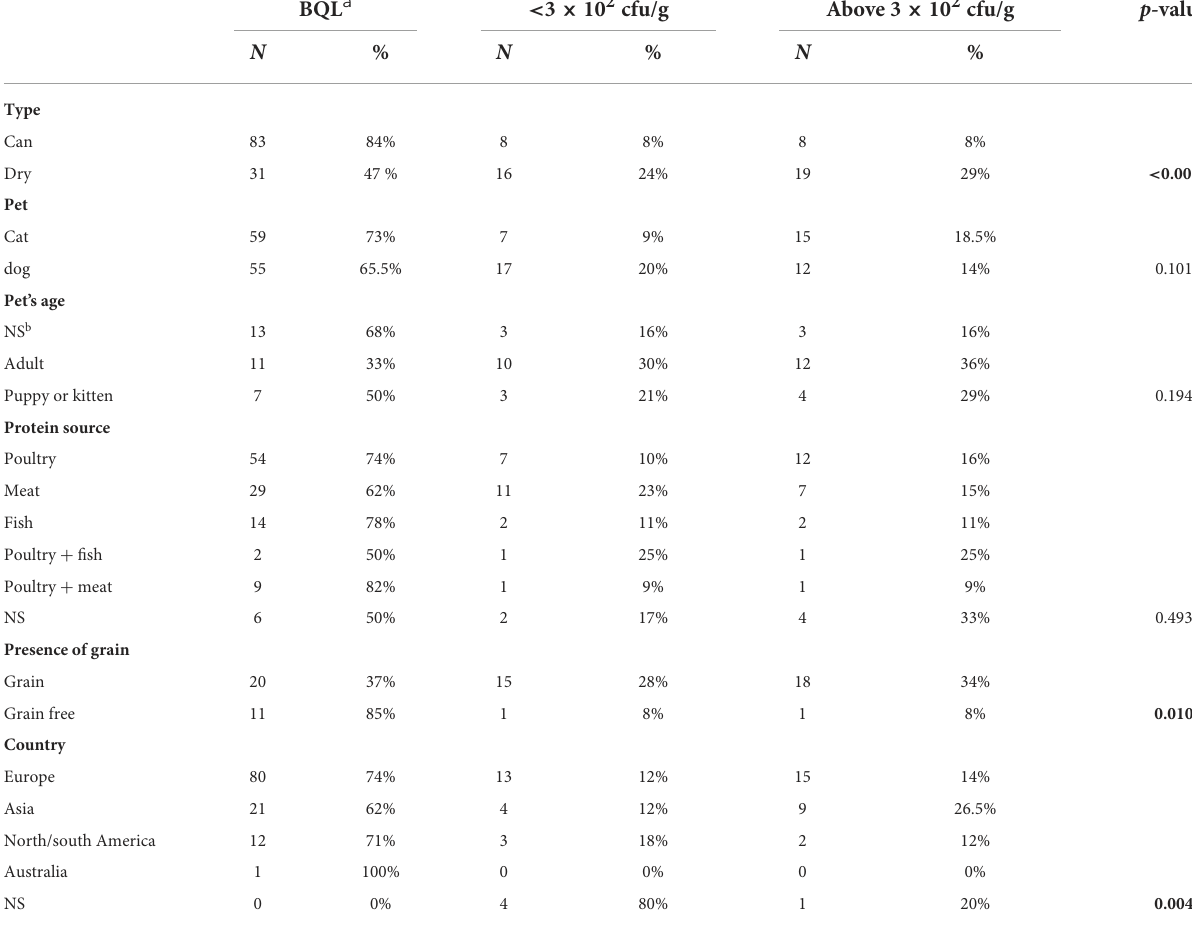
TABLE 3 Microbiological results of presumptive Enterobacteriaceae in dry and canned pet food. BQL